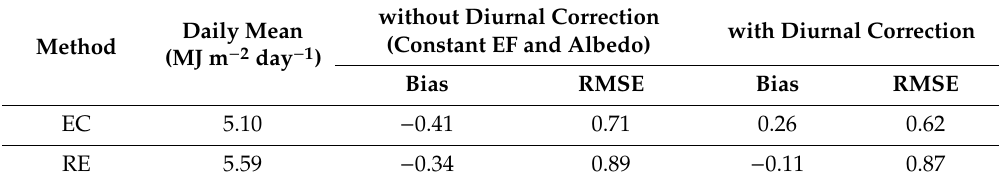
Table 3. The overall statistical of the comparison between without and with diurnal correction for the daily ET estimate from the instantaneous measurements at 1030